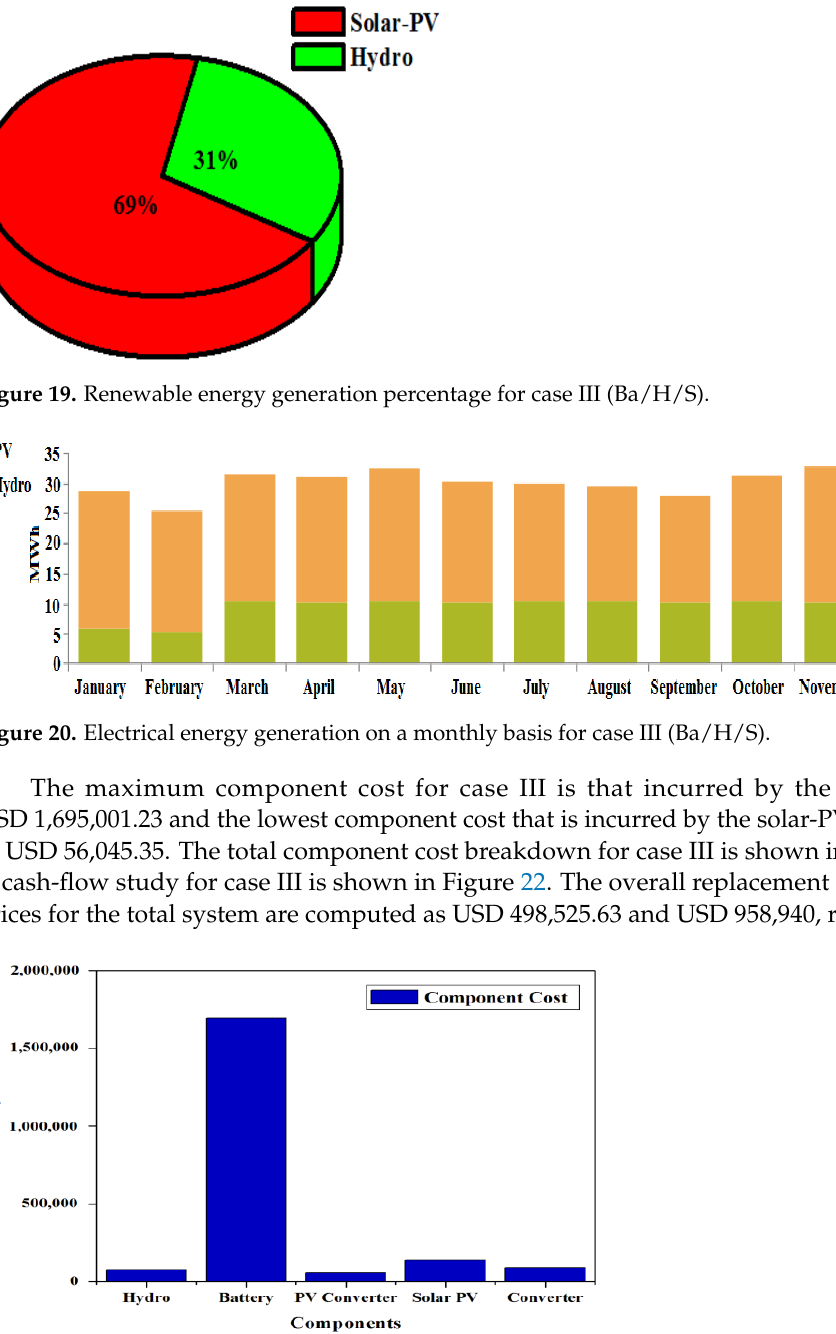
Figure 21. Total component cost breakdown for case III (Ba/H/S).